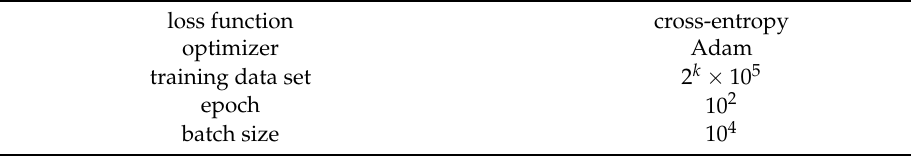
Table 3. Hyperparameters for model training.